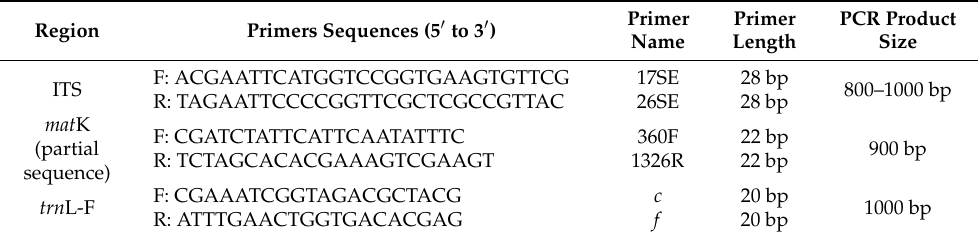
Table 2. Primers information for polymerase chain reaction amplification of nrITS, mat K, and trn L-F regions.